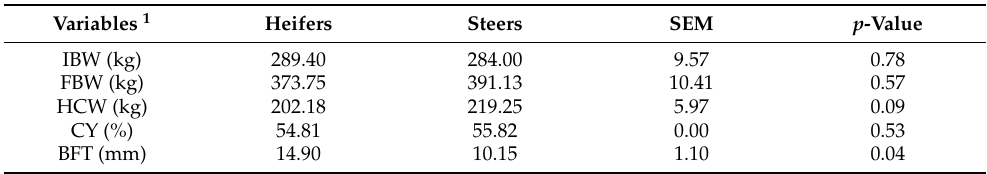
Table 1. Live body weight and carcass traits of immunocastrated F1 Montana-Nellore young heifers and steers feedlot